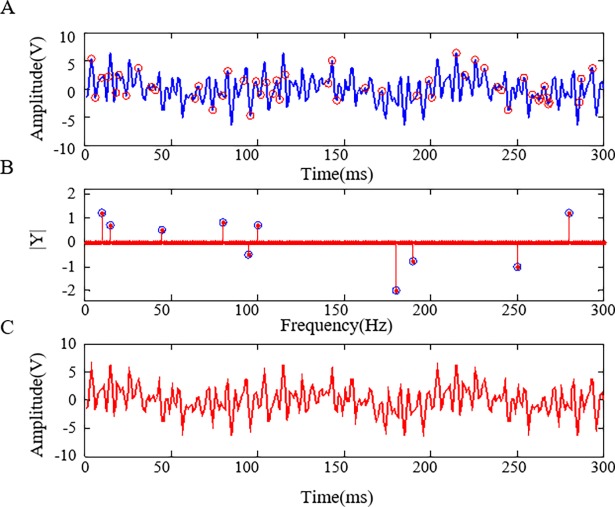
Compressive sampling and recovering of an example signal sparse in the frequency domain.(A) Original signal and the random sampling points. (B) Original and reconstructed coefficients in the frequency domain. (C) Reconstructed signal based on the sparse coefficients.